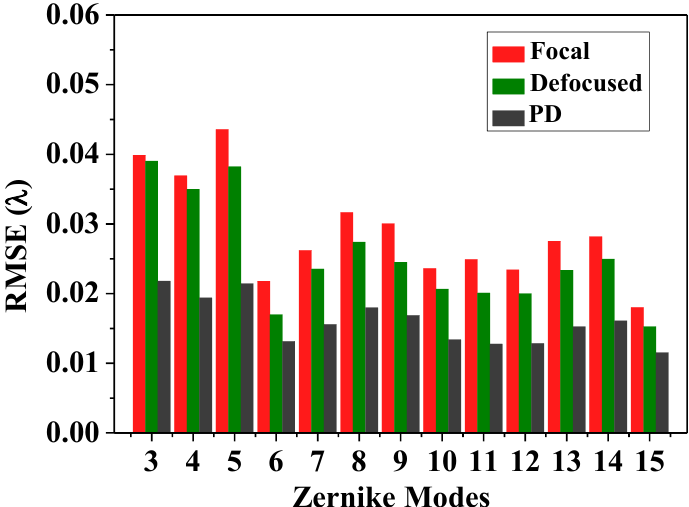
Figure 7. The accuracies (RMSEs: λ ) of each Zernike coefficient estimated by PD-CNN across 3000